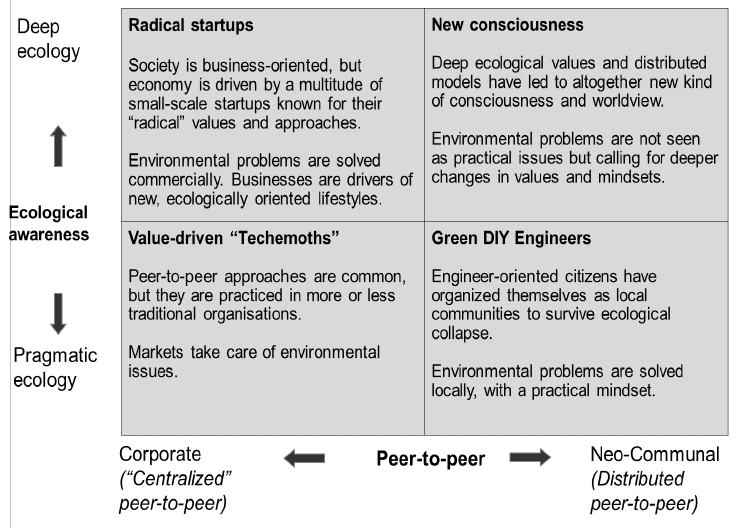
Fig. 3. Four transformative scenarios in the Neo-Carbon Energy project (Heinonen et al., 2015) Tentative scenarios have been tested in the Futures Clinique (a participatory and exploratory future workshop, which is designed to anticipate especially radical futures and surprising effects [i.e. black swans]; see Heinonen and Ruotsalainen, 2013), during which participants (e.g. project members, government, business, and third sector representatives) work